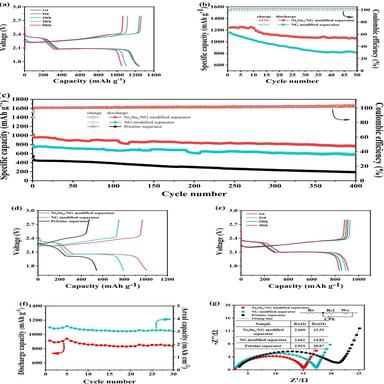
(a) Charge/discharge curves of the battery with Ni3Sn2/NG modified separator at 0.2 C. (b) Cycle performances of the batteries with different separators at 0.2 C for 50 cycles. (c) Cyclic performance of the batteries with different separators at 1 C for 400 cycles. (d) Charge/discharge curves of the batteries with different separators at 1 C. (e) The charge/discharge curves and (f) cyclic performance of the battery with Ni3Sn2/NG modified separator with an areal sulfur loading of 3.6 mg cm2 at current rate